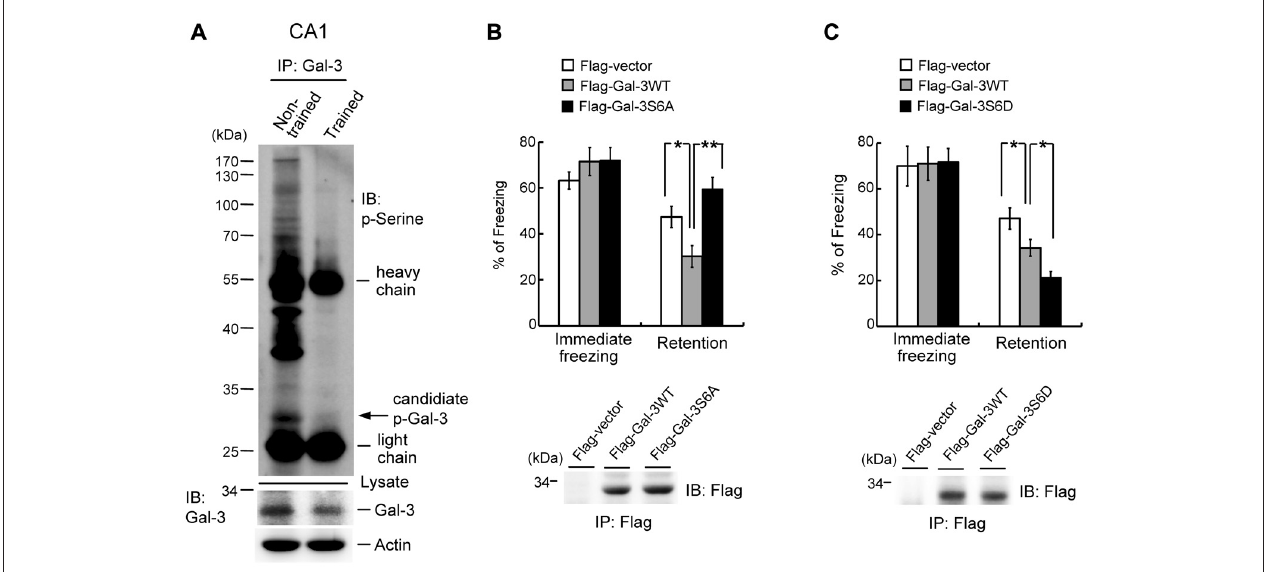
FIGURE 6 | Galectin-3 negatively regulates fear memory through phosphorylation of galectin-3 at Ser-6. (A) Co-IP experiment (immunoprecipitation with anti-galectin-3 antibody and immunoblotting with anti-p-Ser antibody) showing the candidate p-galectin-3 band in non-trained animals in rat CA1 area. This association is dramatically reduced after training (upper panel). Western blot showing the expression level of galectin-3 in trained and non-trained animals (lower panel). Experiments are in two repeats. (B) Immediate freezing response ( F ( 2,21 ) = 0.88, P > 0.05) and retention performance in galectin-3WT and galectin-3S6A-transfected animals ( F ( 2,21 ) = 8.89, P < 0.001; q = 3.49, P < 0.05 comparing the galectin-3WT with Flag-vector group; q = 5.93, P = 0.01 comparing the Flag-galectin-3S6A group with Flag-galectin-3WT group; q = 2.44, P > 0.05 comparing the Flag-galectin-3S6A group with Flag-vector group). N = 8 each group. Immunoprecipitation and immunoblotting against the Flag tag confirming the expression of galectin-3 and galectin-3S6A in Flag-galectin-3WT and Flag-galectin-3S6A-transfected animals, respectively (lower panel). (C) Immediate freezing response ( F ( 2,21 ) = 0.01, P > 0.05) and retention performance in galectin-3WT and galectin-3S6D-transfected animals ( F ( 2,21 ) = 11.86, P < 0.001; q = 3.42, P < 0.05 comparing the galectin-3WT with Flag-vector group; q = 3.47, P < 0.05 comparing the Flag-galectin-3S6D group with Flag-galectin-3WT group; q = 6.89, P < 0.001 comparing the Flag-galectin-3S6D group with Flag-vector group). N = 8 each group. Immunoprecipitation and immunoblotting against the Flag tag confirming the expression of galectin-3 and galectin-3S6D in Flag-galectin-3WT and Flag-galectin-3S6D-transfected animals, respectively (lower panel). Data are mean ± SEM. ∗ P < 0.05, ∗∗ P <